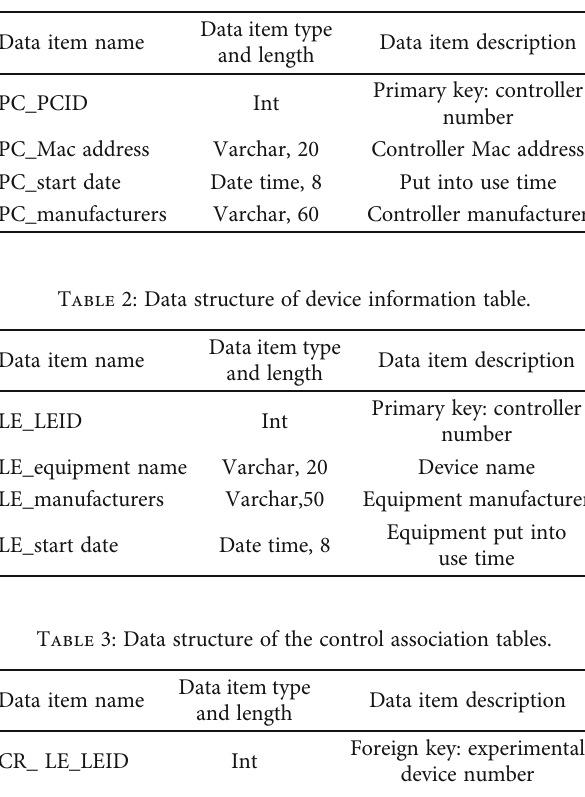
Table 1: Power control table.